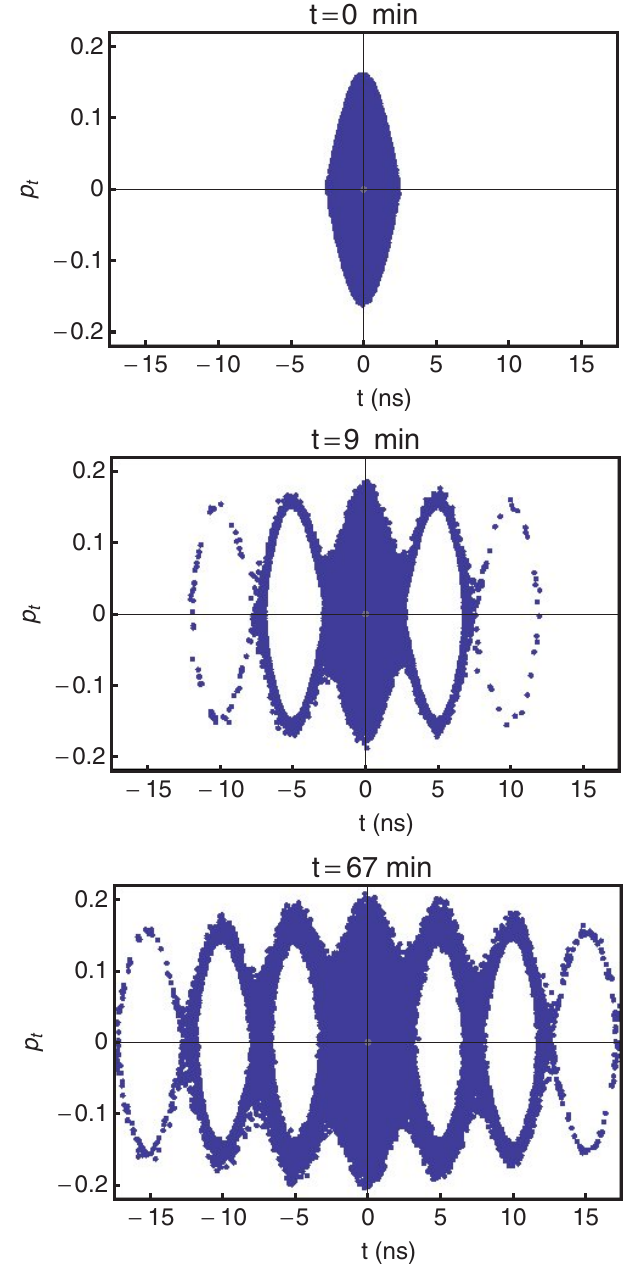
FIG. 6. (Color) A simulated bunch under influence of IBS only in longitudinal phase space at different times. Each point repre- sents one particle out of 50 000. The center of the bunch is located in the central bucket at t ¼ 0 . The longitudinal momen- tum is defined as p t ¼ (cid:1) (cid:1) (cid:1) 0 , where (cid:1) 0 is the Lorentz factor of the synchronous particle. The figure shows an idealized situ- ation, where all particles start in the central bucket (reality is different because of the rf gymnastics). The distribution at 67 min was used as starting conditions in the longitudinal plane for the full tracking, due to its similarity with the measured bunch profile in Fig. 4. For speed, the smooth lattice approxi- mation was used.